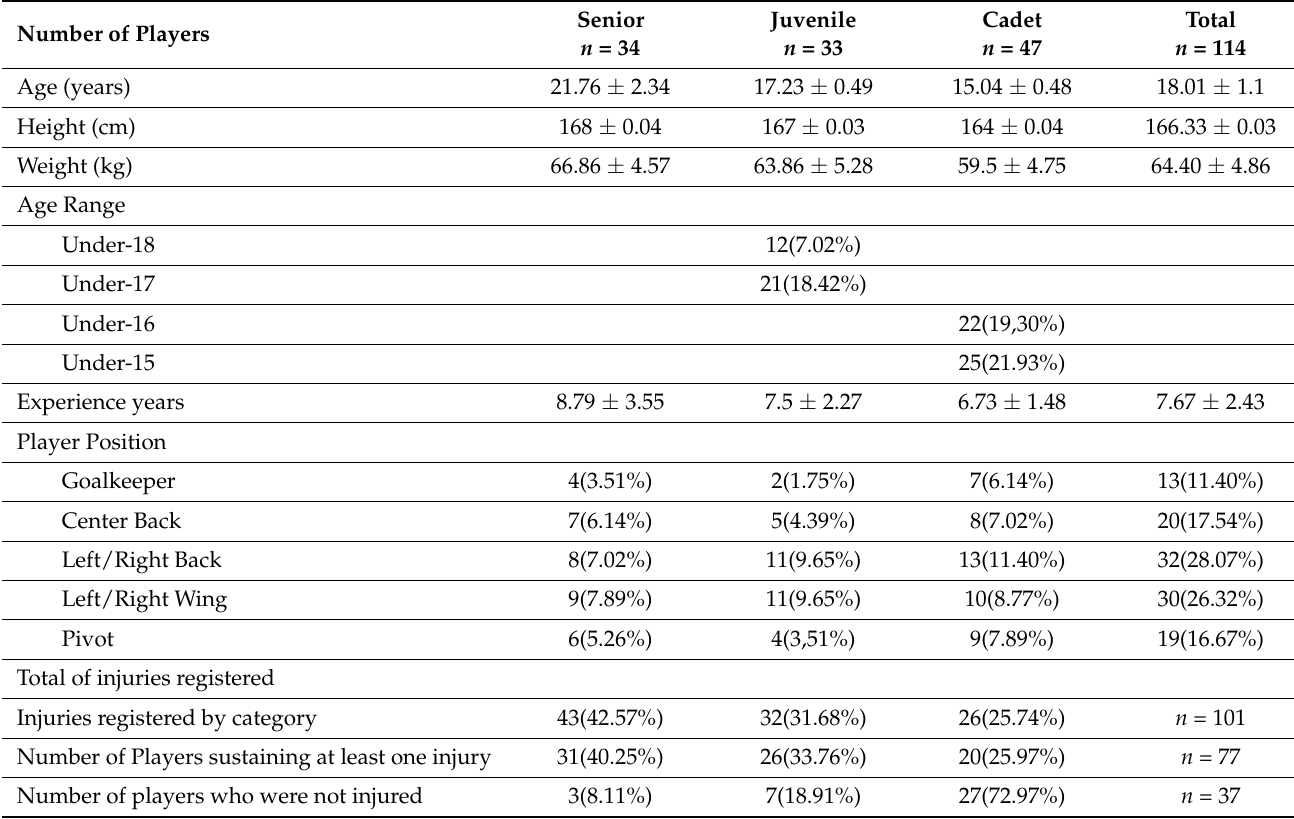
Table 1. Players’ characteristics and total number of injuries